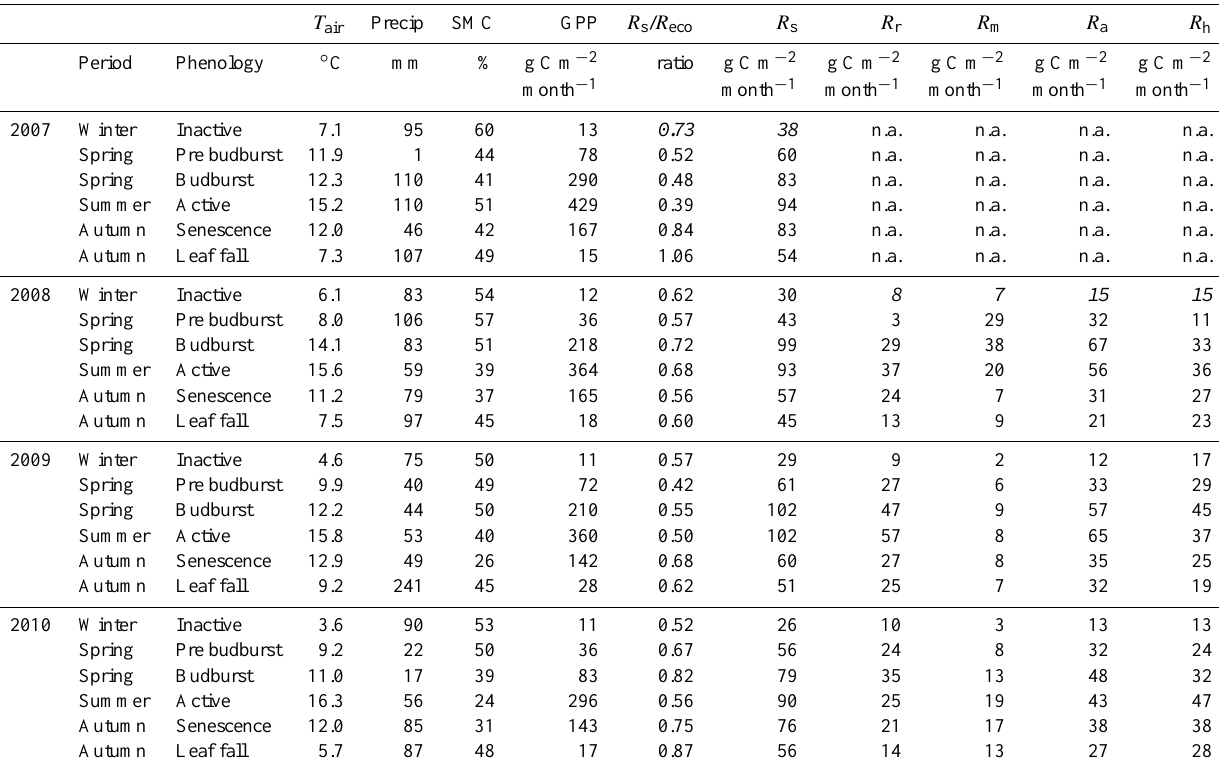
Table 4. Monthly ecosystem C fluxes for gross primary productivity (GPP) and soil respiration fluxes (in gCm − 2 month − 1 ) averaged over particular phenological periods at the Straits Enclosure, Alice Holt forest from 2007 to 2010 together with air temperature ( T air ) , precipitation sums (Precip), volumetric soil moisture content (SMC; v / v ) and the corresponding C flux ratios. Soil respiration ( R s ) component fluxes included replacements of missing values due to late start of monitoring or system failure by temperature regression (shown in italics; n.a. denotes no data available). Phenological periods (for the tree canopy) correspond to: Inactive : December–March; pre budburst : April; budburst : May; active : June–August; senescence : September–October; leaf fall : November. See Table 3 for explanation of additional